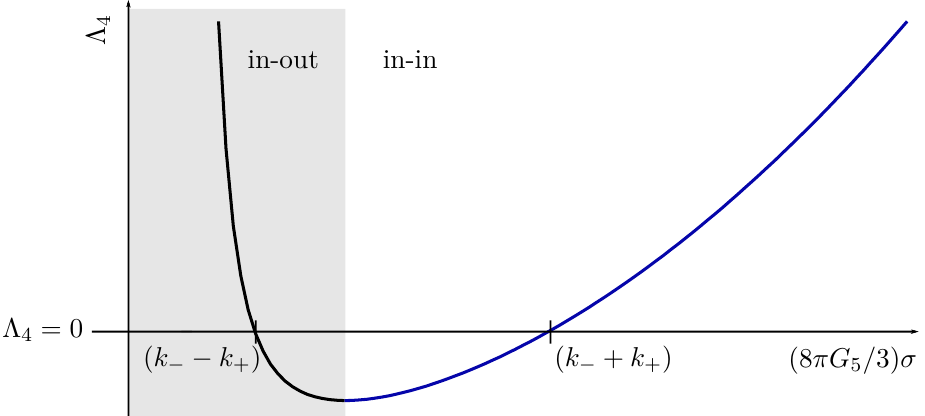
Figure 4. The four dimensional cosmological constant on the brane as a function of its tension. The curve in the shaded region on the left represents the shellworld (inside-outside), while the one to the right is the RS braneworld (inside-inside). The tension corresponding to a Minkowski brane are represented on the horizontal